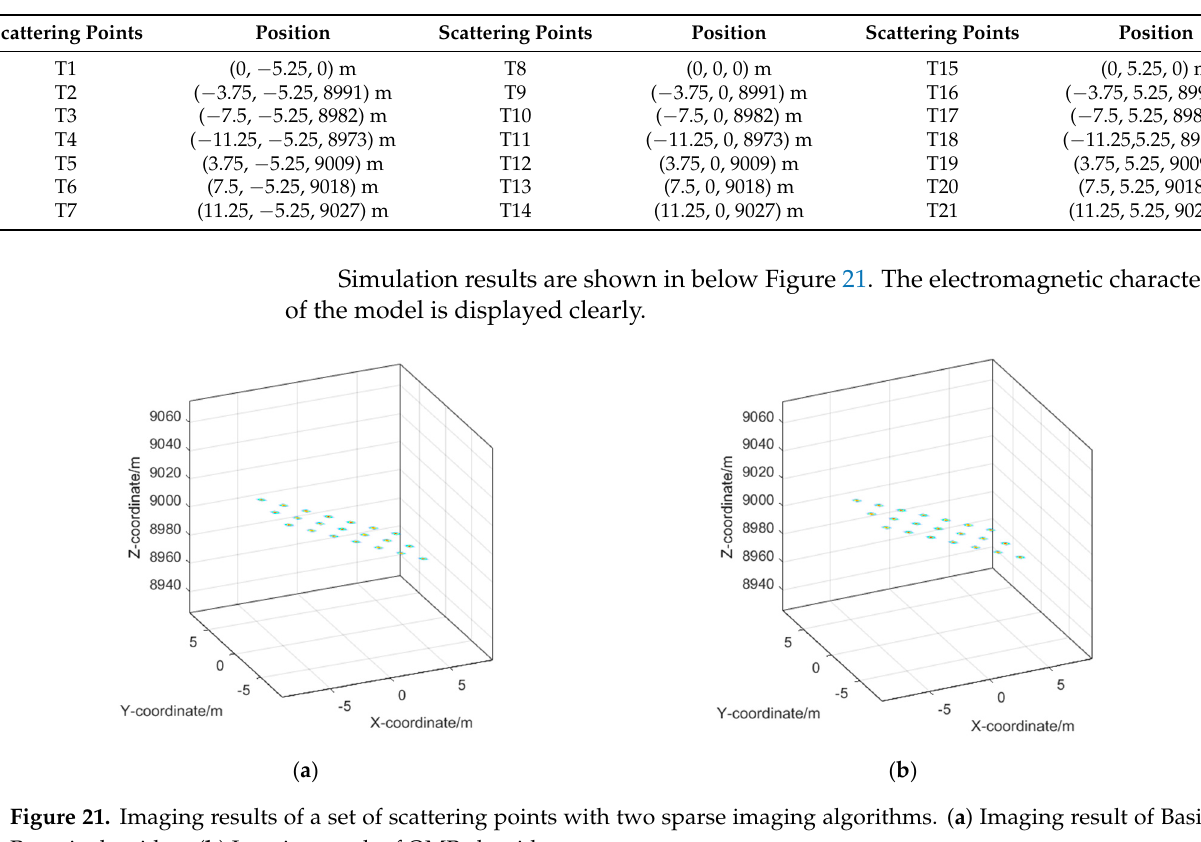
Table 3. Target information.